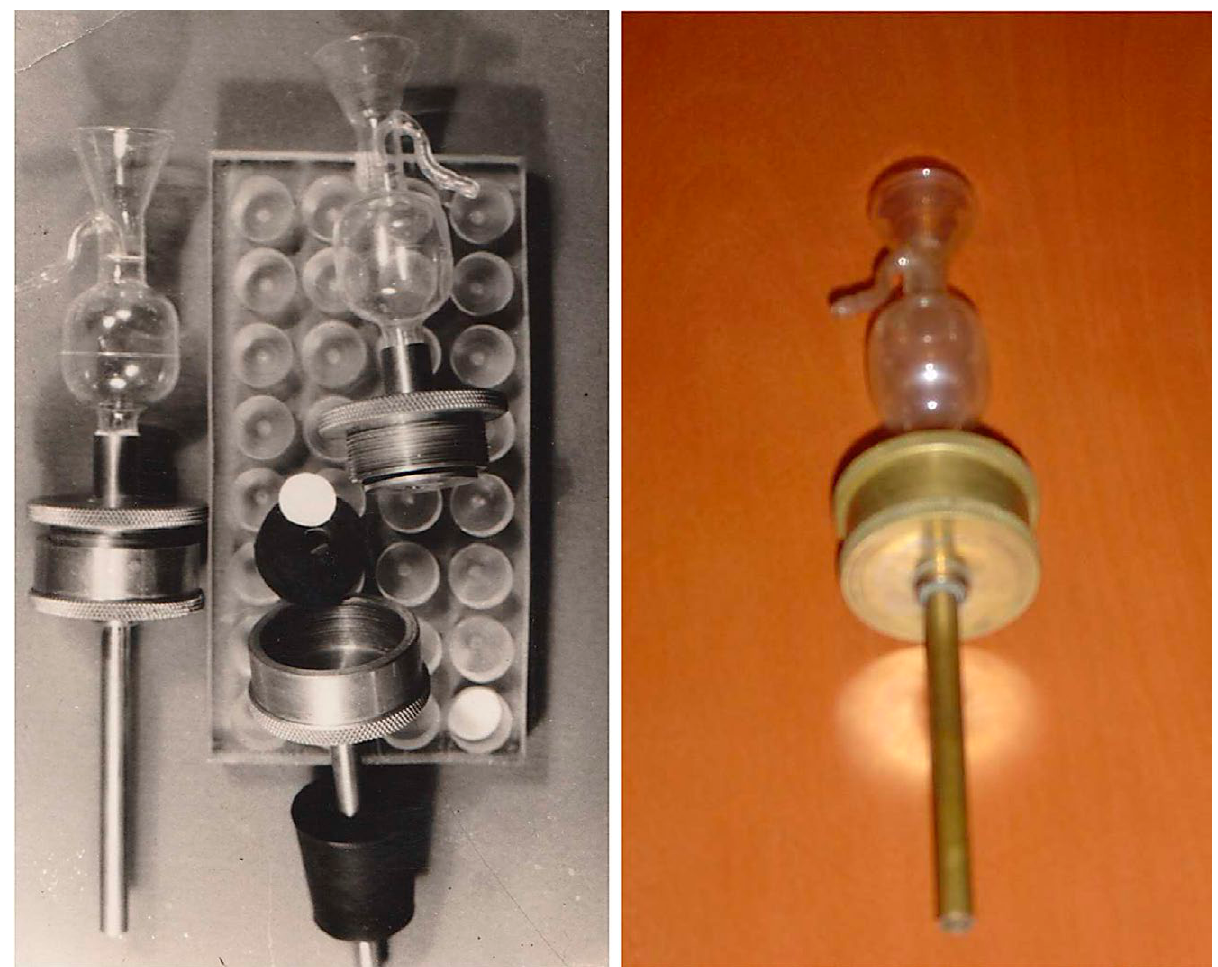
Fig. 9. – Seawater filtration equipment, one of the few remaining devices designed by Margalef. The glass part is an automatic volume- dispenser system (Margalef 1954c). (Photography: M. Alcaraz).